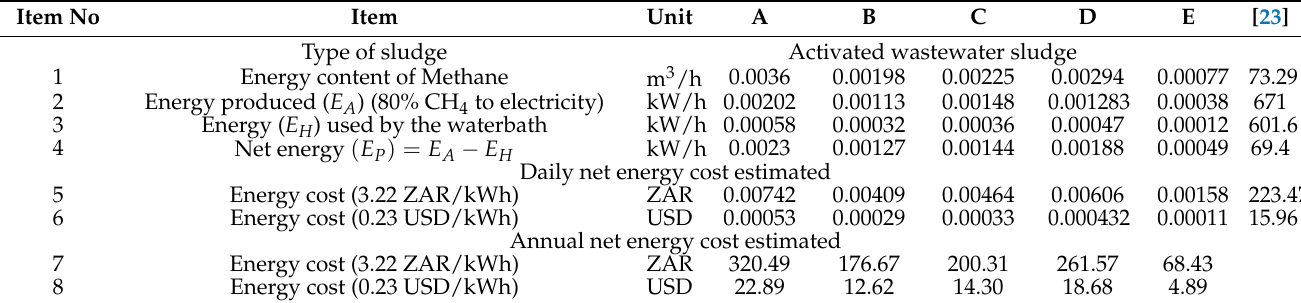
Table 2. Cost estimation for the energy produced from 0.3 L